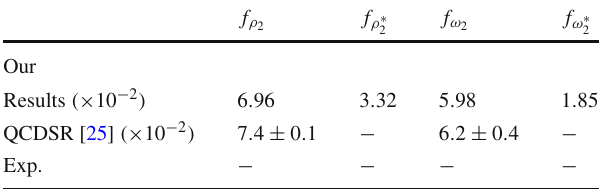
Table 6 Decay constants of the axial-tensor mesons at T = 0 and comparison of the numerical results with other theoretical predictions and